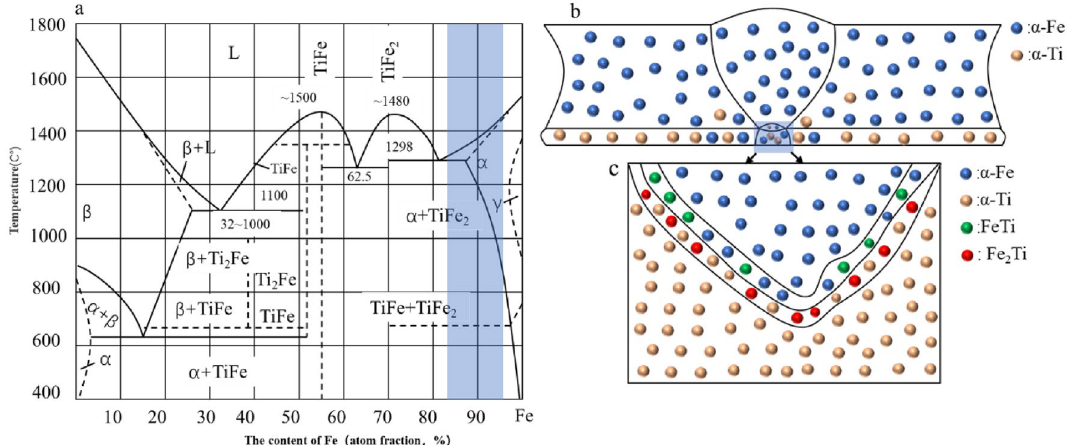
Figure 11. Schematics representation of formation process of FeTi and Fe 2 Ti compounds. (a) PHASE diagram of Ti-Fe and their compounds. (b) Final elements distribution of Titanium and carbon steel compound welded joints. (c) Magnification of ( b ) at the marked zone.